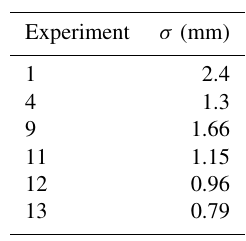
Table 2. Vertical precision estimates for each experiment based on the standard deviation ( σ ) in the distribution of the elevations for the non-moving